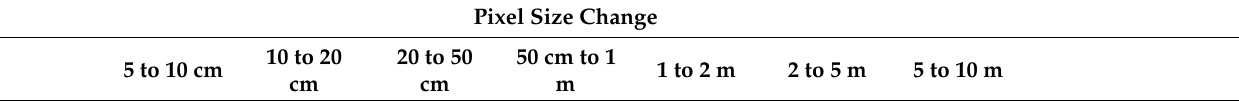
Table 2. Change in LS factor and soil erosion with the variation of DEM resolution.